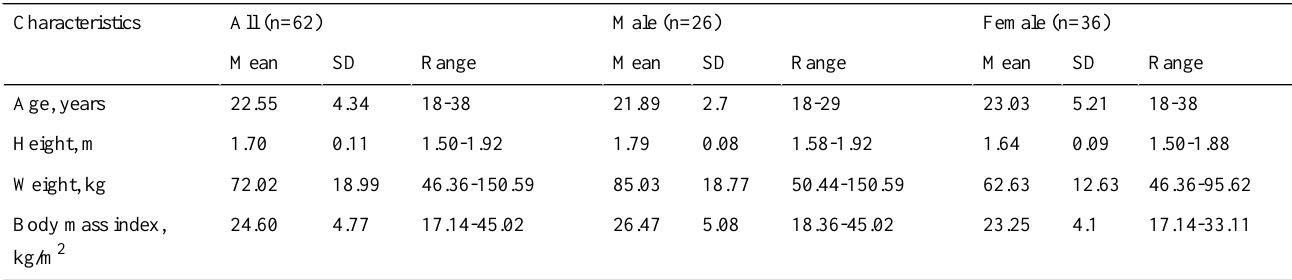
Table 1. Physical characteristics of participants (N=62).